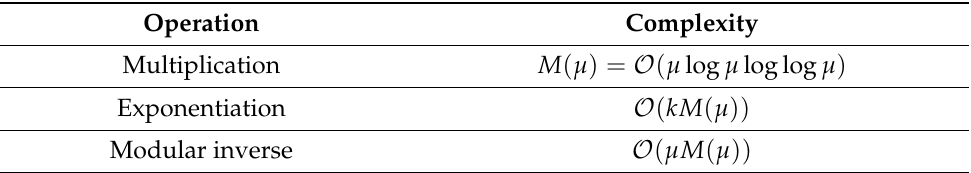
Table 1. Computational complexity for µ -bit